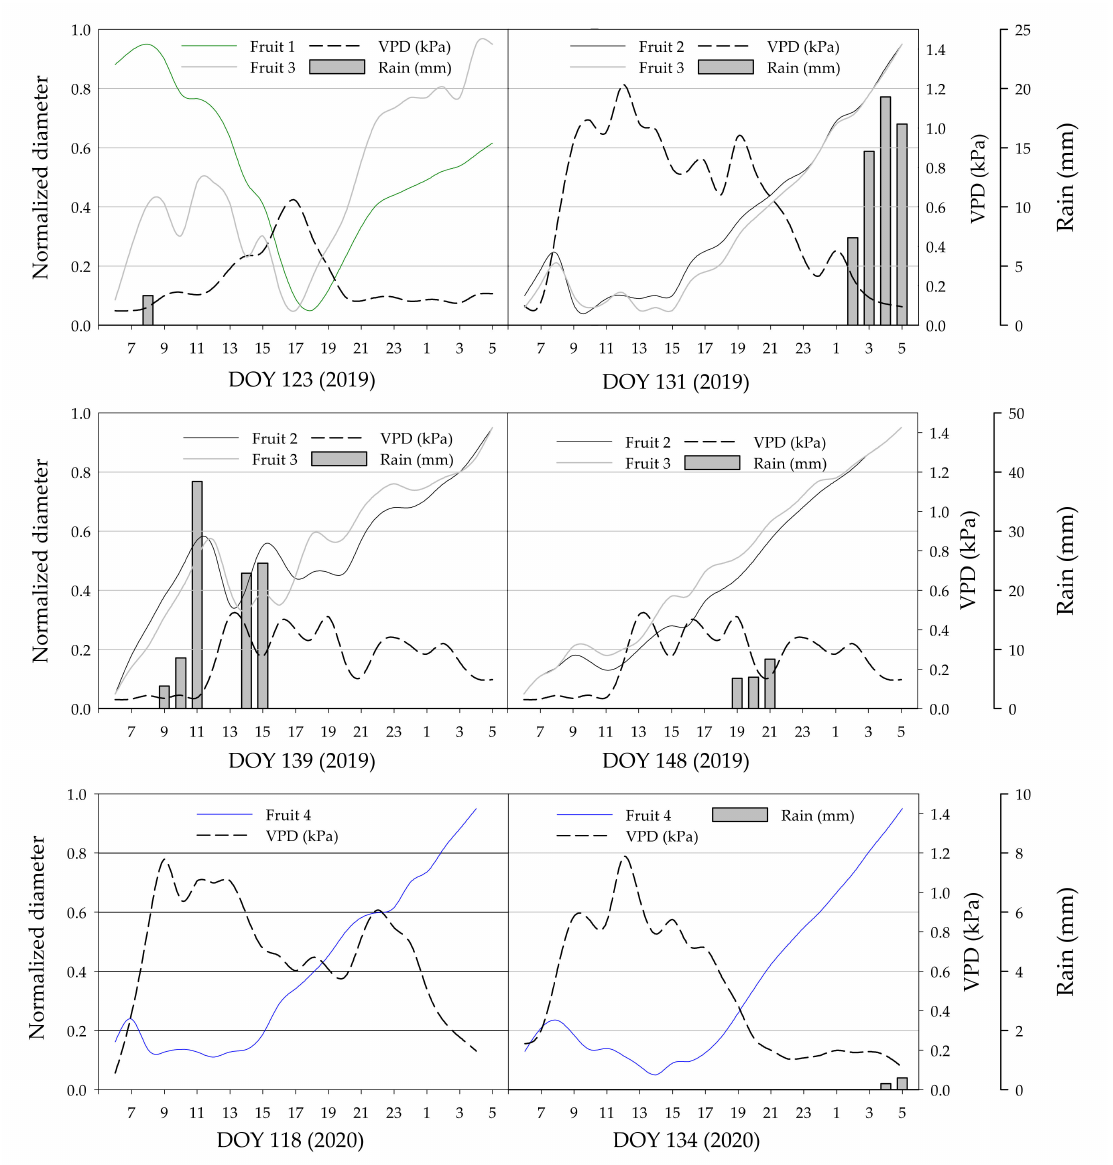
Figure 3. Most representative daily trends of transversal diameter, VPD and rain in the first periods (growth stage 3) in 2019 and 2020. The three-phase daily trend on DOY 118 in 2020 and DOY 131 in 2019; the v-trend of fruit 1 on DOY 123 in 2019; the rain influence on DOY 123, 131 and 139 in 2019 and DOY 141 in